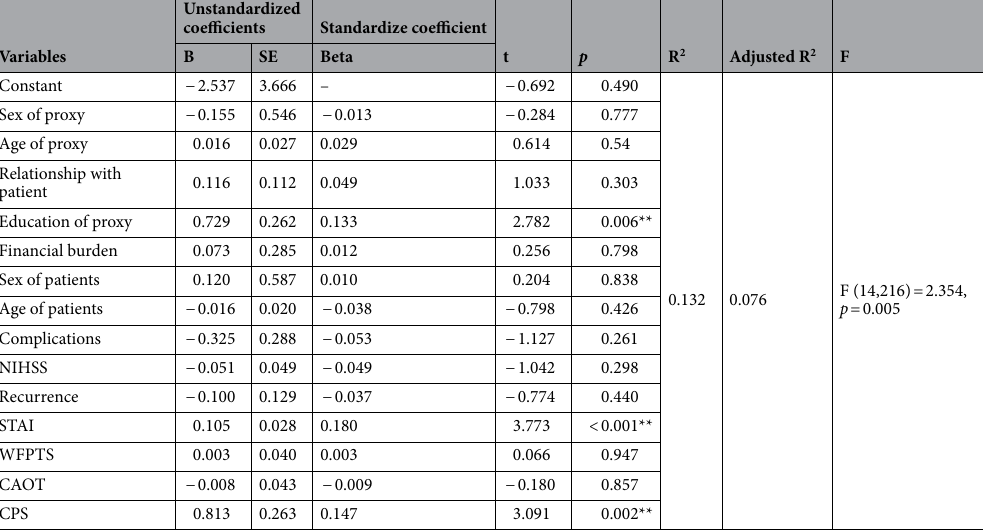
Table 5. Ridge regression analysis results (Y: Time consuming). * p < 0.05 ** p < 0.01. Dummy variables were set for categorical variables. Sex: 1 = male, 2 = female; Education degree: 1 = primary and below, 2 = junior middle school, 3 = senior high school, 4 = bachelor, 5 = master; Relationship with patient: 1 = sons or daughters, 2 = spouse, 3 = parents, 4 = brother or sister, 5 = others; Economic burden: 1 = none, 2 = mild, 3 = middle, 4 =